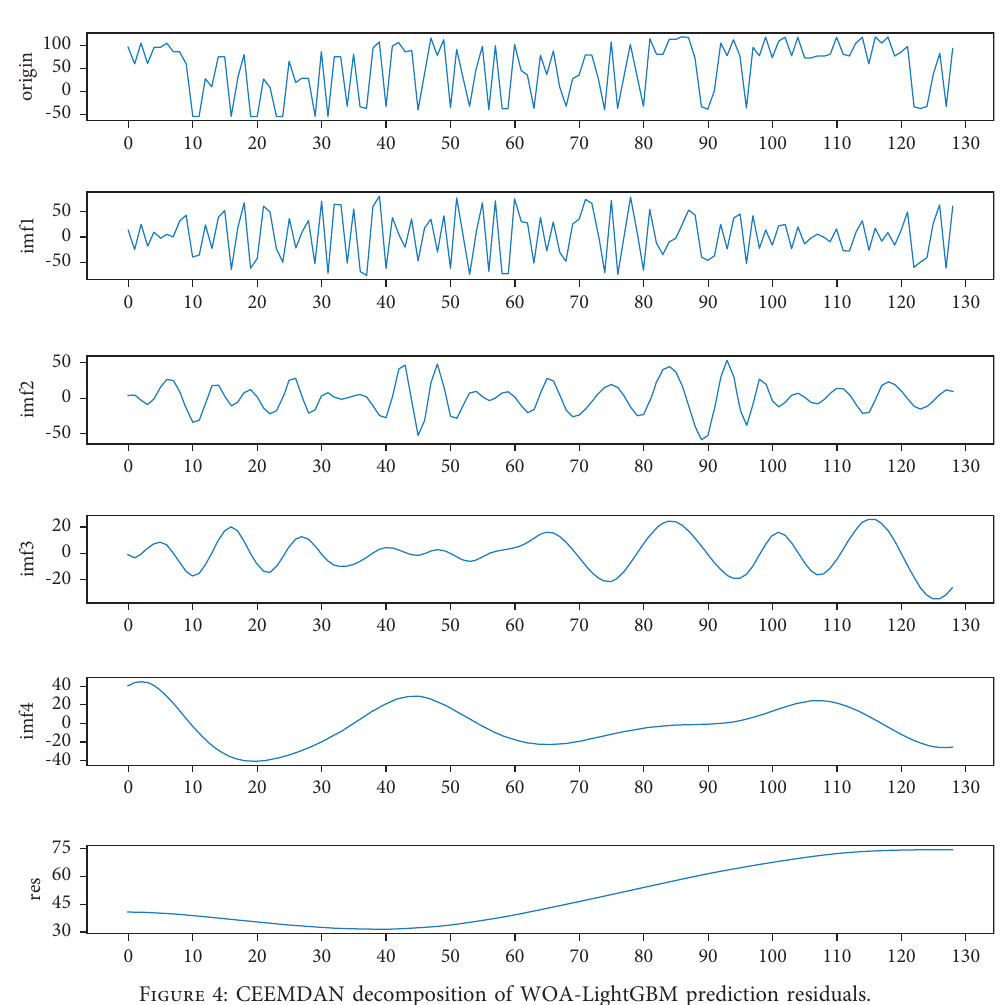
Figure 4: CEEMDAN decomposition of WOA-LightGBM prediction